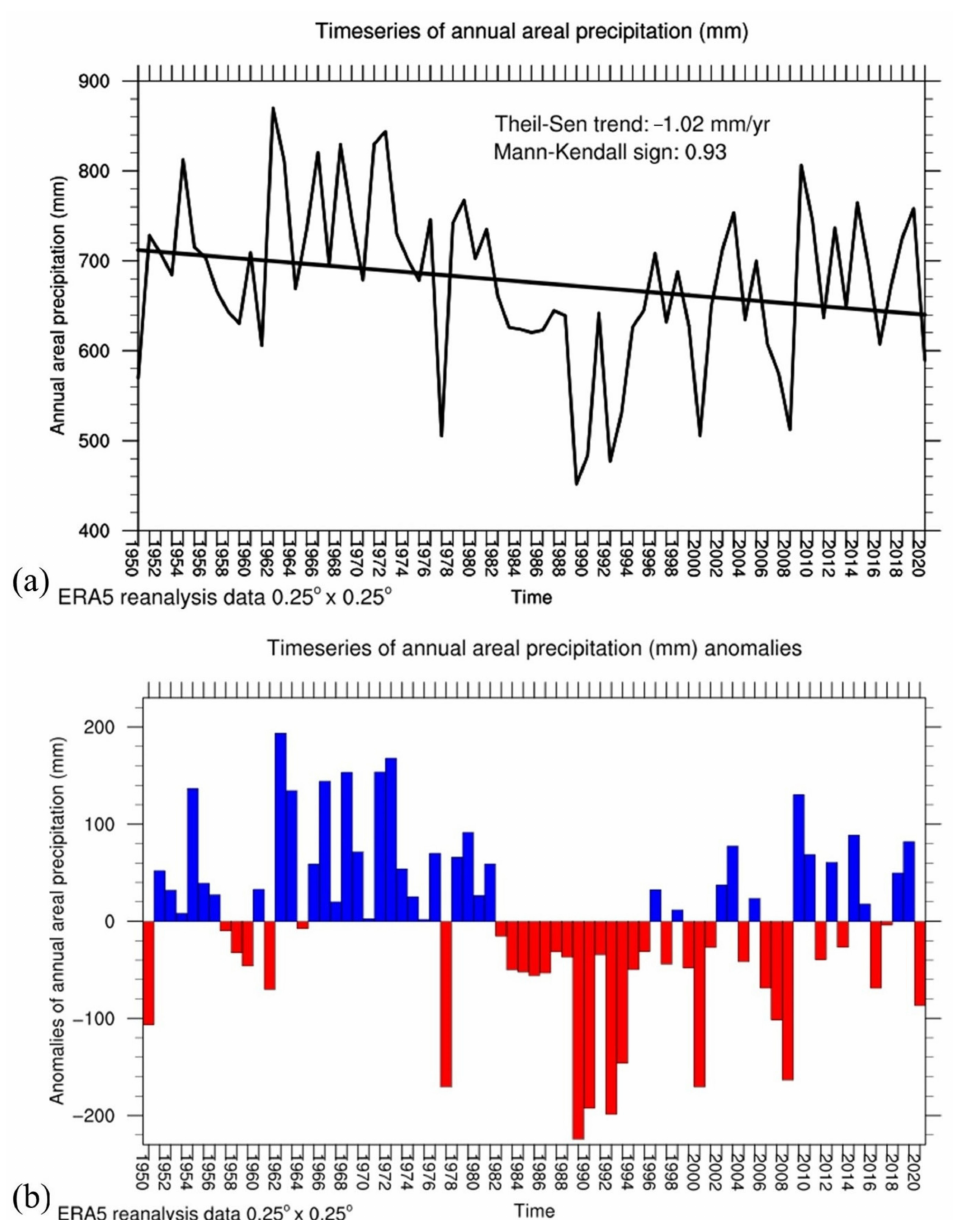
Figure 7. ( a ) Time series from 1950 to 2020 of annual areal precipitation across the study area. Theil– Sen trend, trend line, and Mann–Kendall significance are also demonstrated; ( b ) Same as ( a ) but for precipitation anomalies with 1950–2020 average precipitation used as